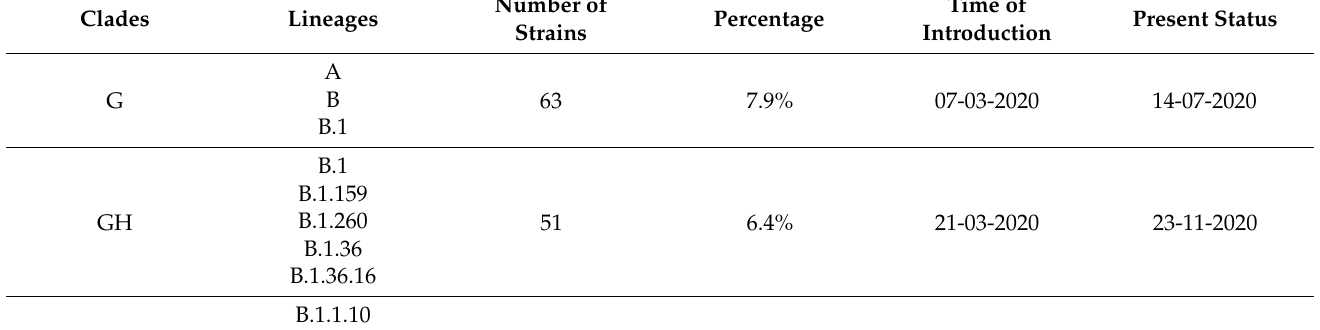
Time Number of Percentage Strains